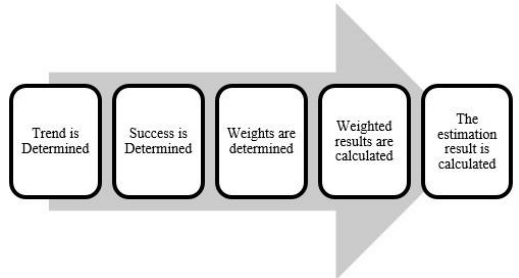
Figure 5. Boost Functional Clustering Algorithm Flowchart